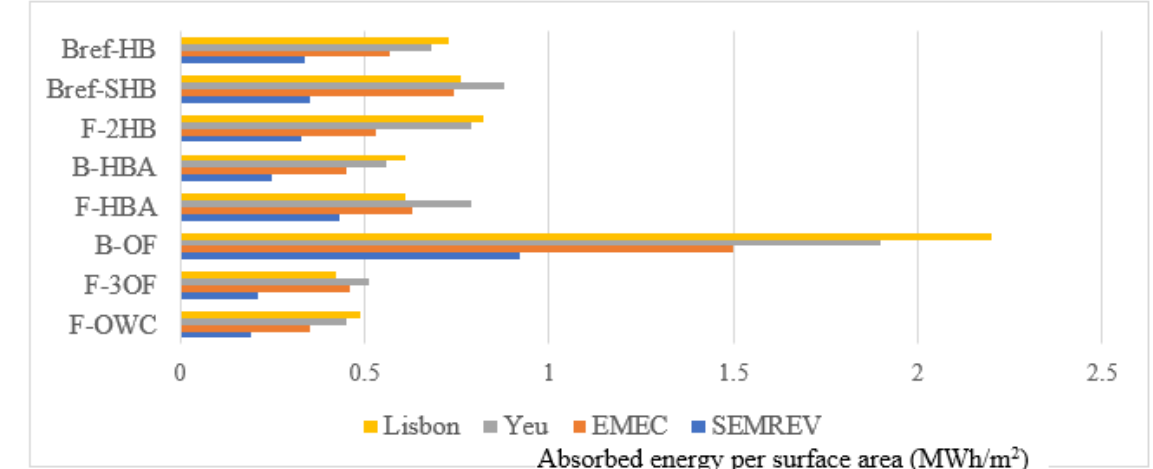
Figure 3. Performance comparison of the absorbed energy per surface area of WECs.